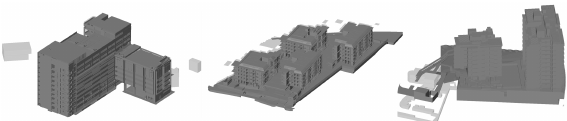
Figure 15. Visualisation of resulting CityGML files from the BCA Academy dataset (left), Estate A dataset (center) and Estate B dataset (right).